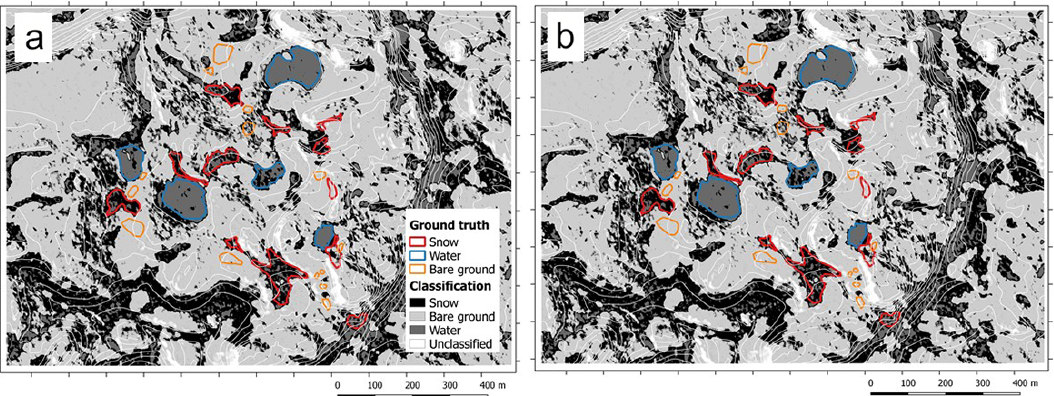
Figure 13. Classification results using (a) backscattering threshold water with wet snow at − 20.5dB, (b) backscattering threshold water with wet snow at − 19.5dB.